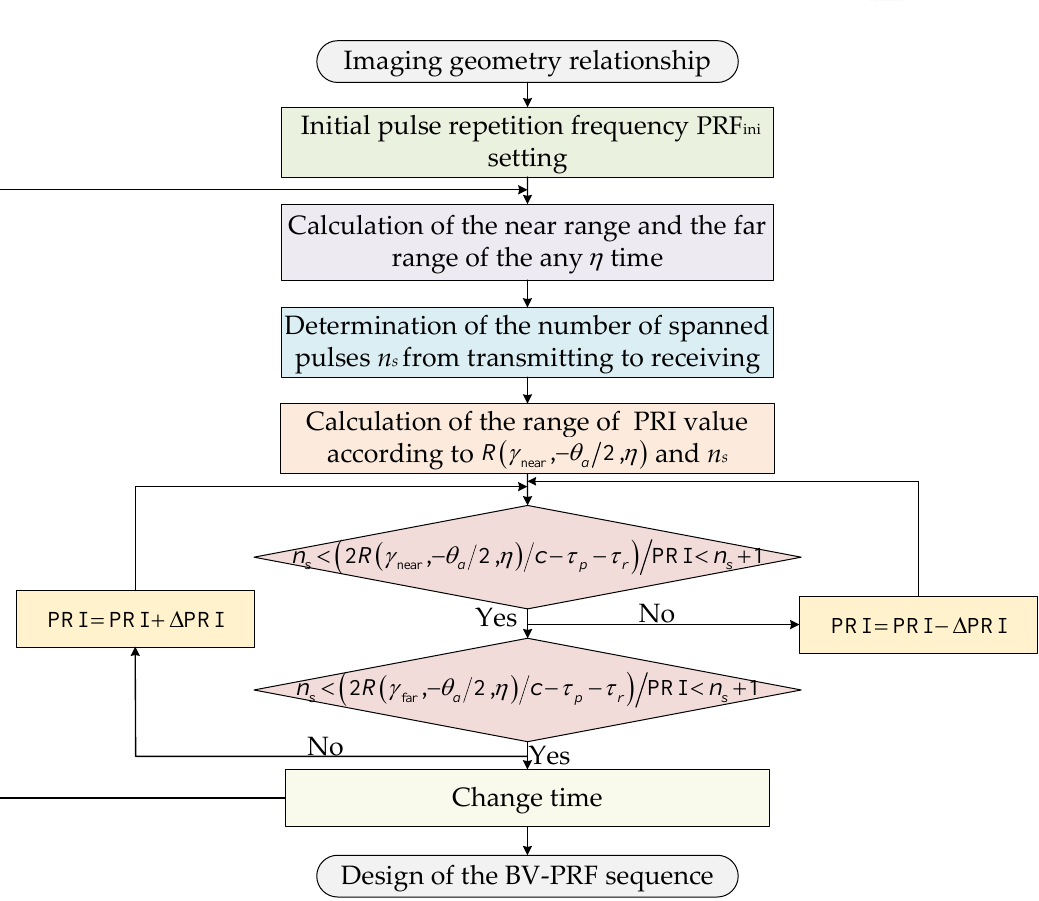
Figure 4. Flowchart of the design of the BV-PRF sequence.